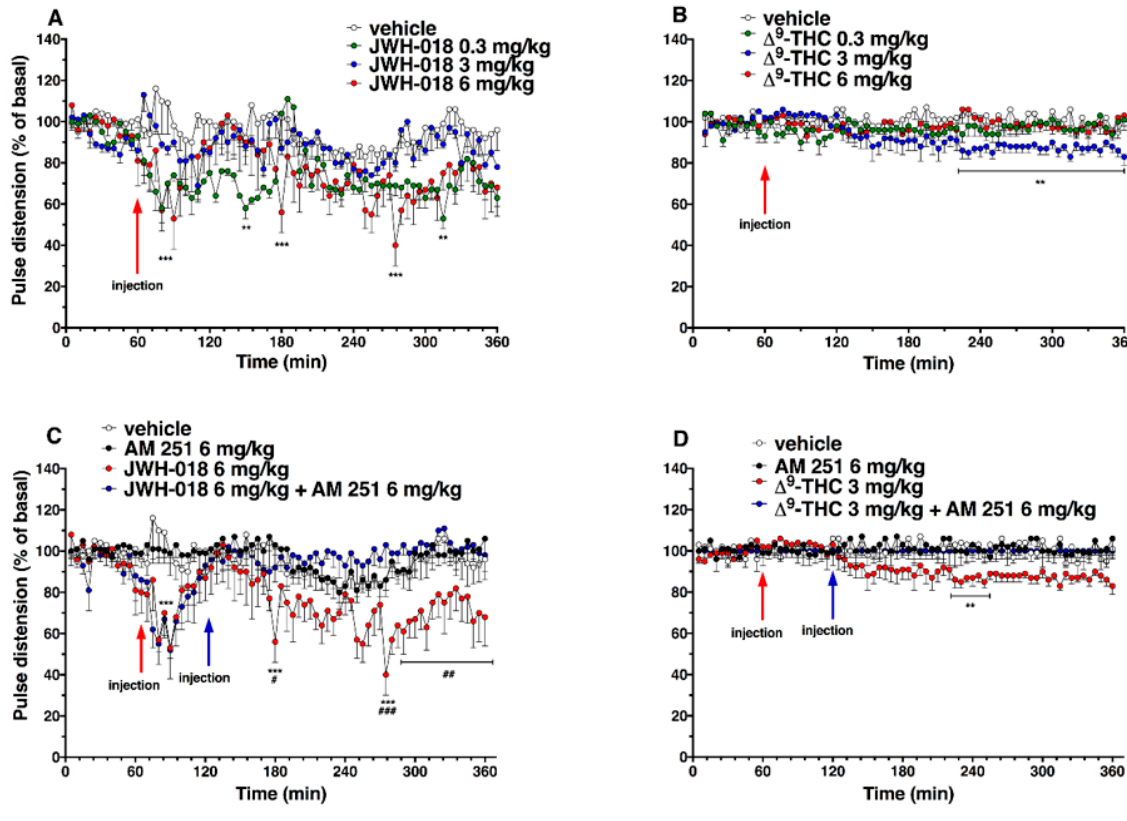
Figure 7. Effect of systemic administration of JWH-018 (0.3–6 mg/kg, panel ( A )) and ∆ 9 -THC (0.3–6 mg/kg, panel ( B )) on pulse distension. Data are expressed as percentage of basal values in the form MEAN ± SEM of 6 different evaluations for JWH-018 experiments and MEAN ± SEM of 8 different evaluations for JWH-018 experiments. Statistical analysis was performed by two-way ANOVA, fol- lowed by Bonferroni’s test for multiple comparisons. ** p < 0.01 *** p < 0.001 versus vehicle. Interac- tion of JWH-018 (6 mg/kg i.p, panel ( C )) and ∆ 9 -THC (6 mg/kg, panel ( D )) with the selective CB 1 receptor antagonist AM 251 (6 mg/kg, i.p.). Data is expressed as percentage of basal values in the form MEAN ± SEM of 8 different evaluations for each group. Statistical analysis was performed by two-way ANOVA, followed by Bonferroni’s test for multiple comparisons. ** p < 0.01 *** p < 0.001 versus vehicle and # p <0.05, ## p <0.01, ### p < 0.001 versus AM 251 + agonists.